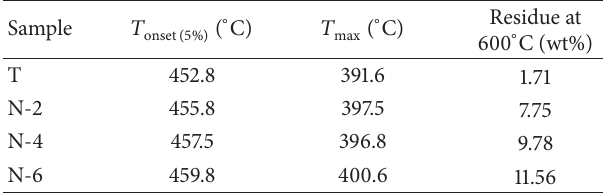
Table 1: The data of DMTA for PPO/PA66 blend and nanocompos- ites.